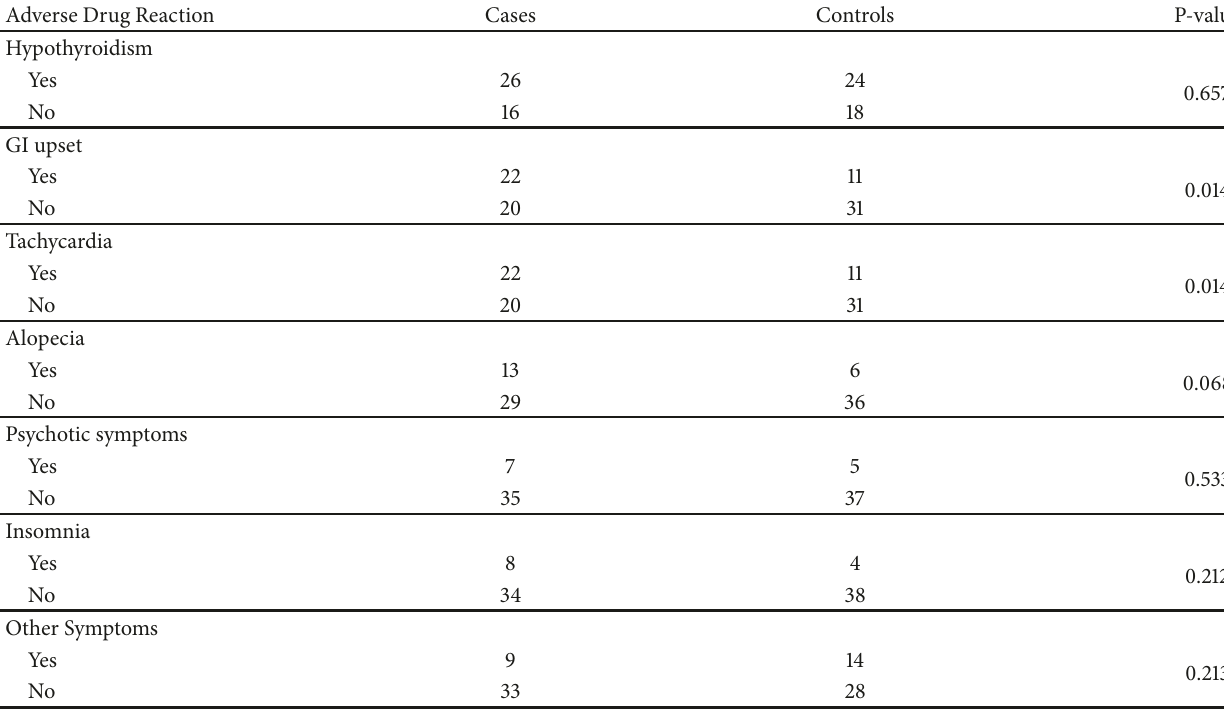
Table 2: Summary of major adverse drug reactions among MDR-TB patients and their association with incident gout. Adverse Drug Reaction